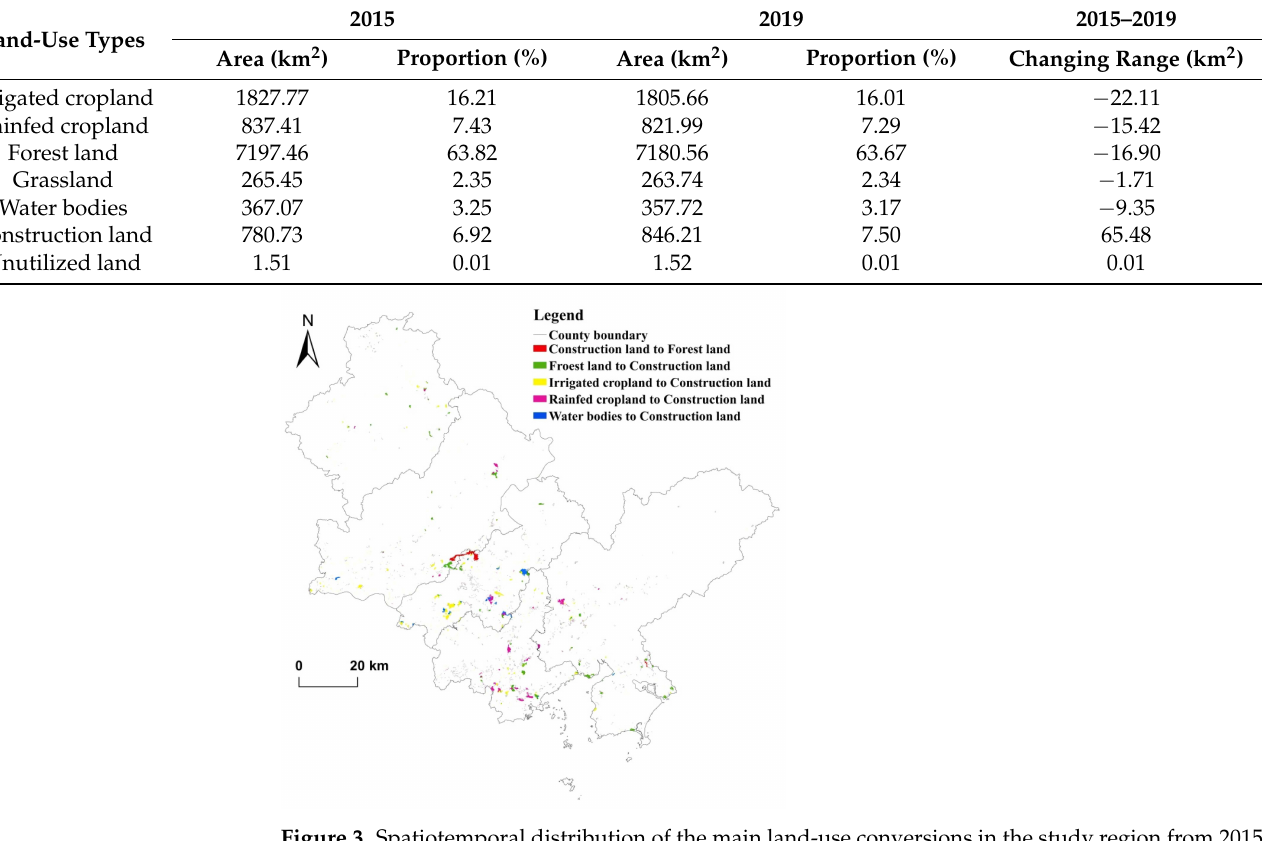
Figure 3. Spatiotemporal distribution of the main land-use conversions in the study region from 2015 to 2019.